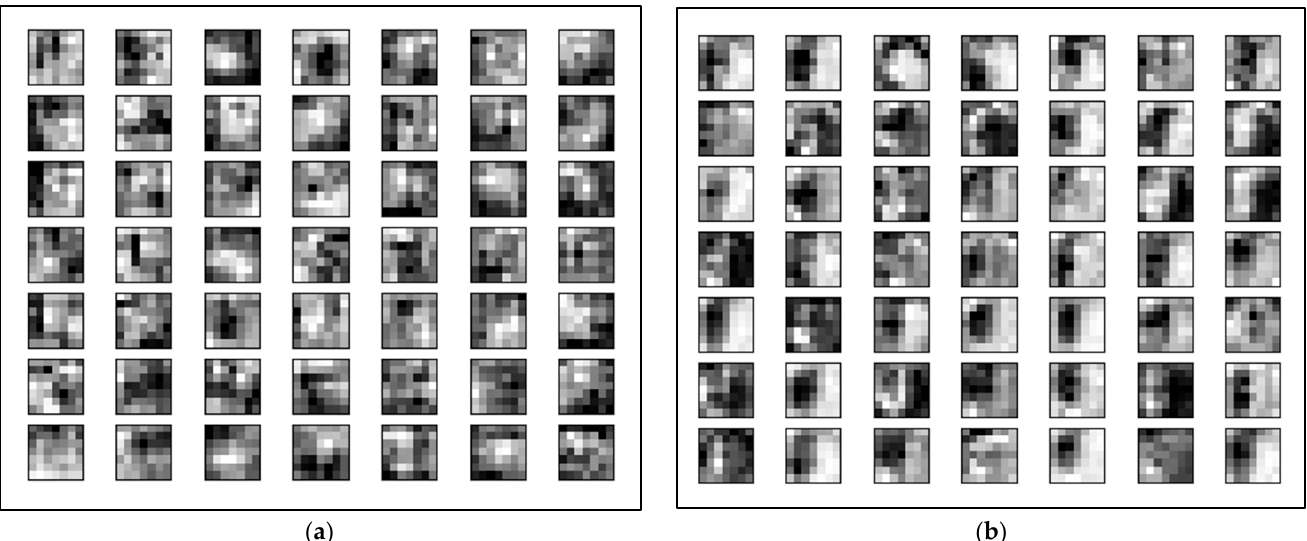
Figure 13. Feature learn by DenseNet-121 before and after Bayesian: ( a ) Before applying Bayesian optimization; ( b ) After applying Bayesian optimization.